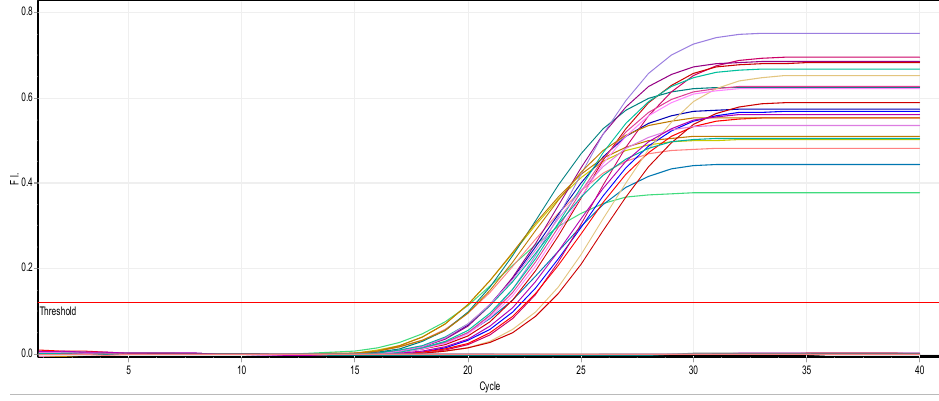
Figure 6. Real-time PCR results of the kfu gene.